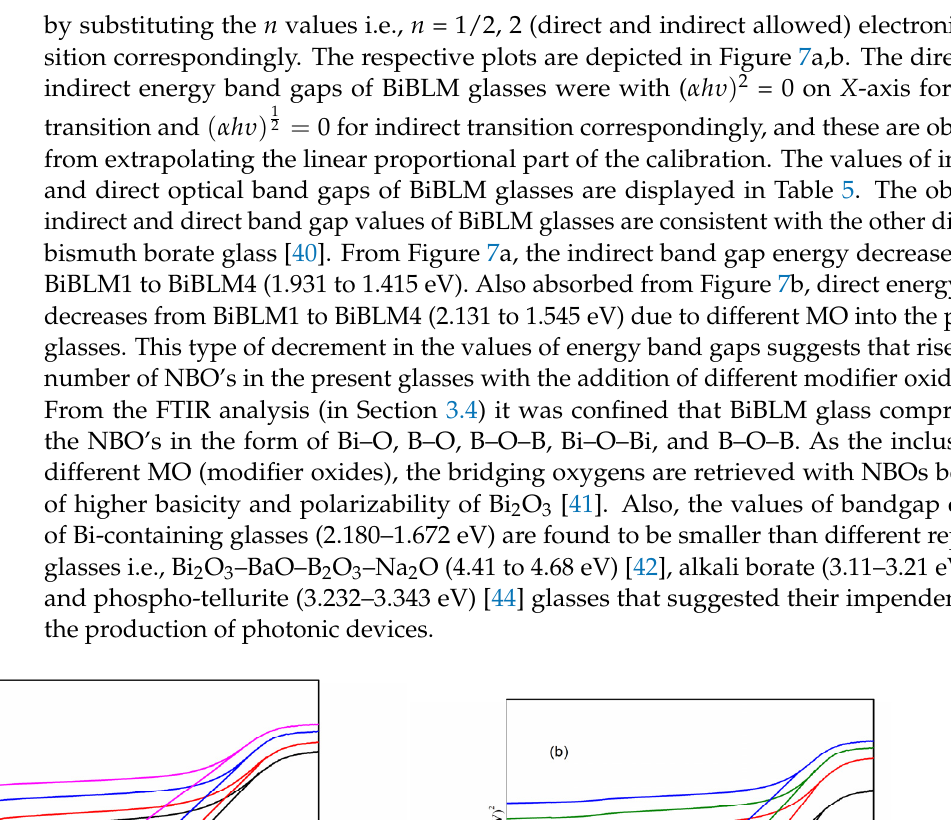
where α (cid:2868) is a constant and ∆𝐸 represents the width of the band tails of an electron in different states in the forbidden band gap and these are known as the UE. The above Equation (6), also may be redrafted as